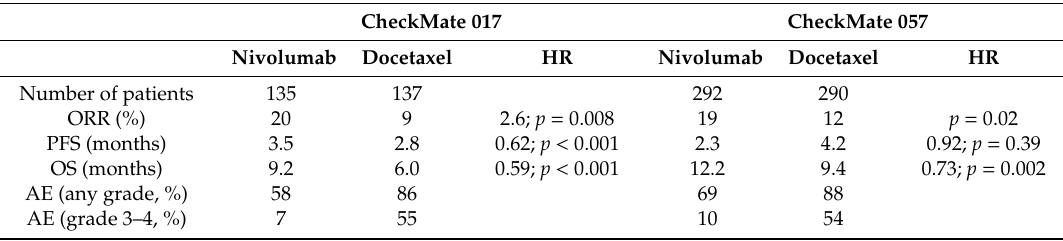
Table 1. Nivolumab for previously treated non-small-cell lung cancer—CheckMate 017 / 057 [2,3]. CheckMate 017 CheckMate 057 Nivolumab Docetaxel HR Nivolumab Docetaxel